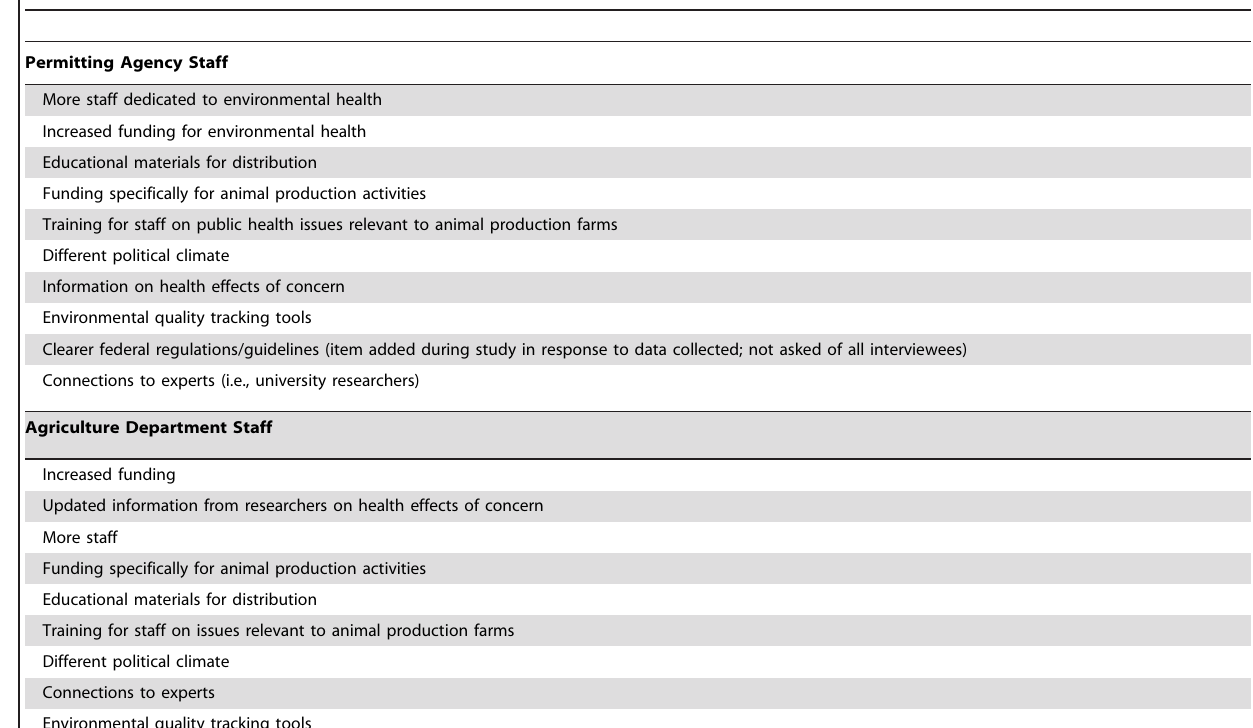
Table 2. Needs indicated by interviewees from list (Descending